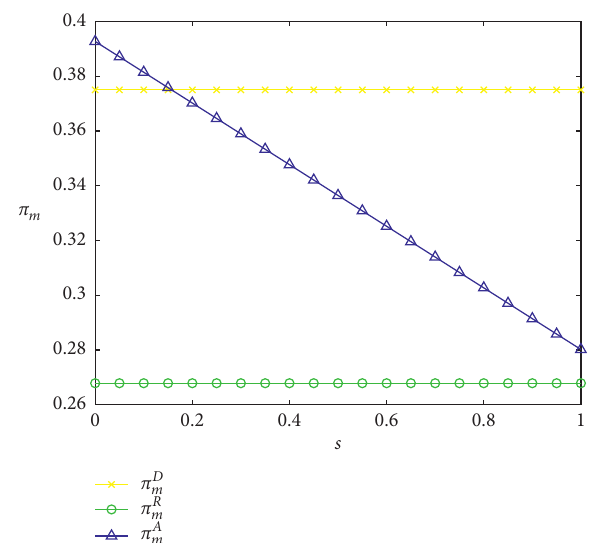
Figure 4: Impact of the commission fee on the manufacturer’s